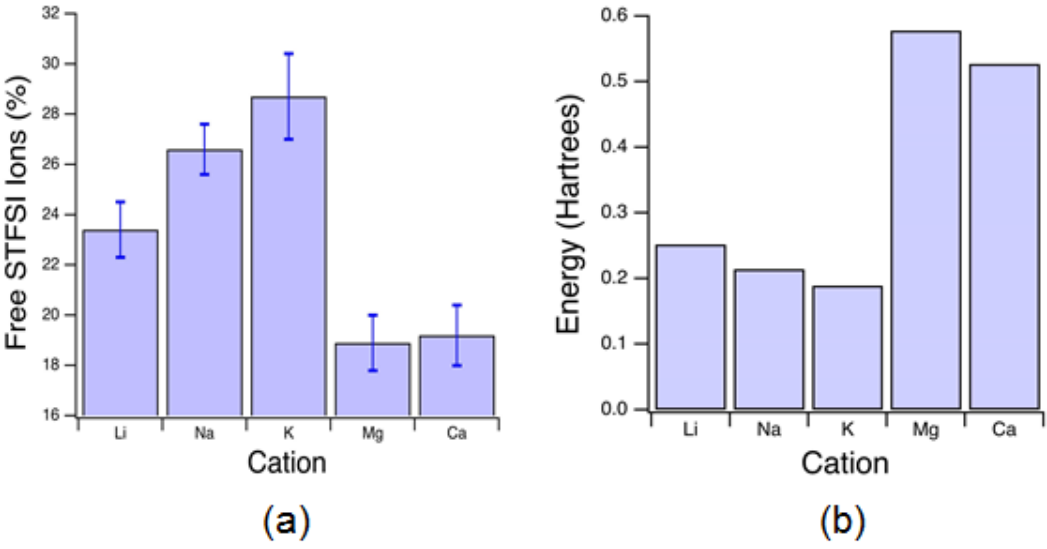
Figure 9. ( a ) Measured free ion percentages from Raman spectroscopy for PEG 31 DA-x-STFSIX electrolytes where X is the variable cation, and ( b ) DFT predicted dissociation energies for STFSIX ion pairs where X is the variable cation.